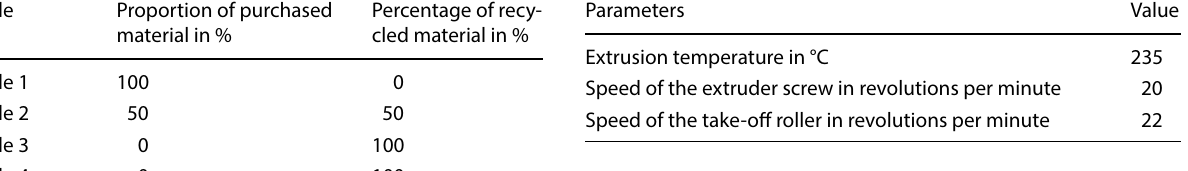
Table 1 Mixing ratios of the samples tested Sample